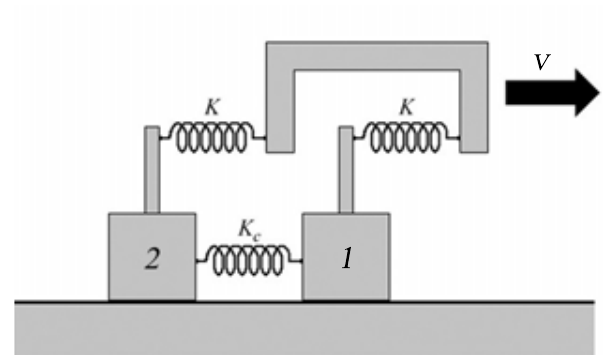
Fig. 1. The two-block